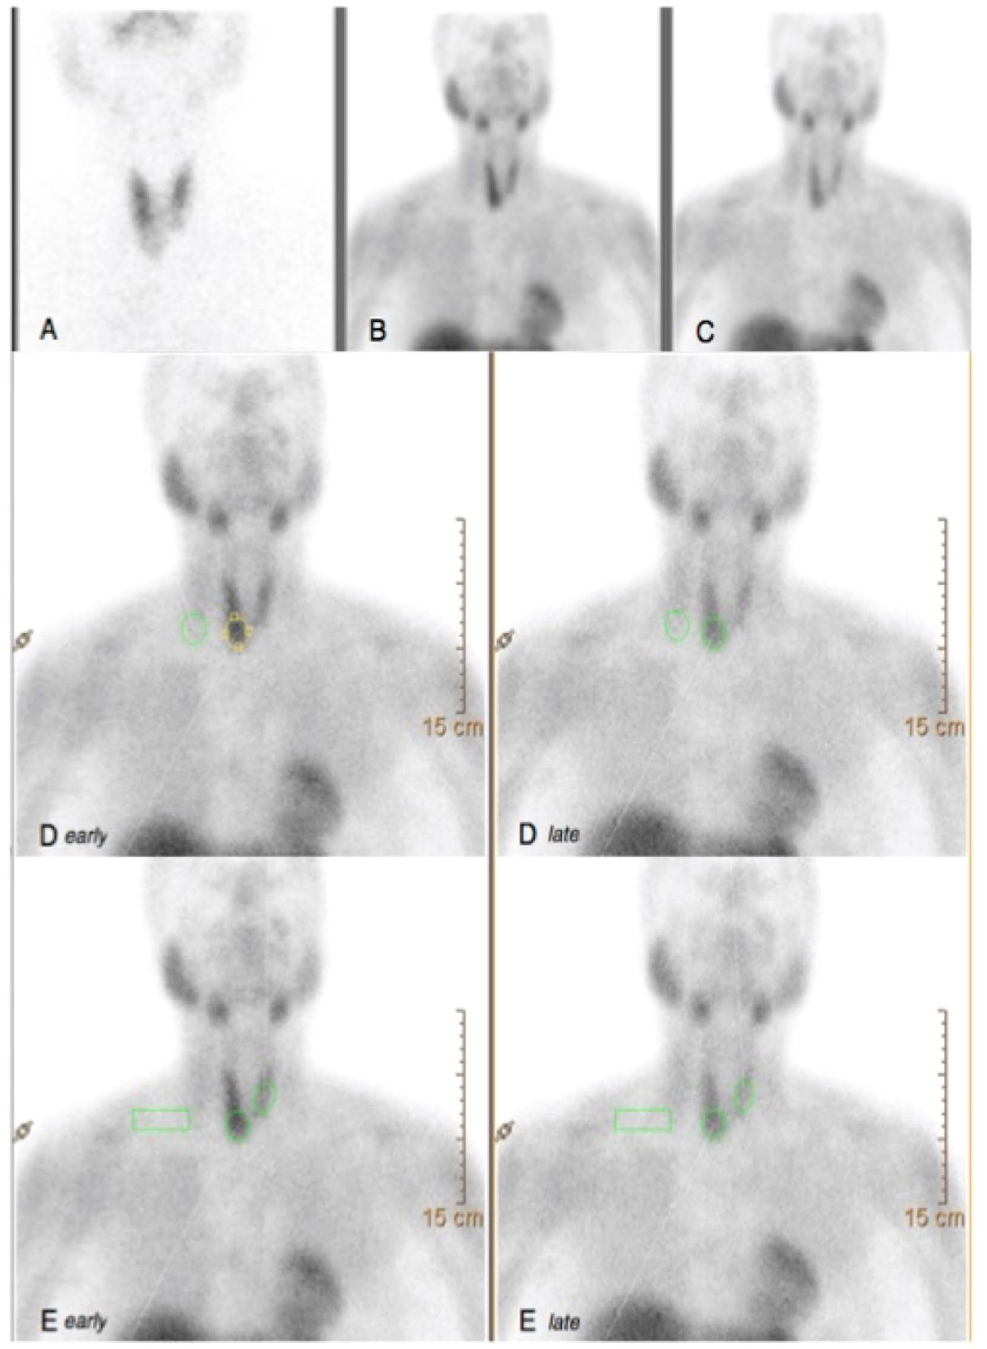
Figure 1. Fifty-two year-old woman with a single nodule located in the right lobe. The nodule (35 mm in maximum diameter) presented a 4B pattern at US (TI-RADS classification). ( A ) 99m Tc-pertechnetate (111 MBq) thyroid scintigraphy showed a well defined cold area in the lower third of the right lobe, corresponding to the US nodule. Cytopathological findings were conclusive for a class IV lesion according to the Bethesda system. ( B , C ) 99m Tc-MIBI (370 MBq) thyroid scintigraphy obtained 10 (early) and 60 (late) minutes after tracer administration. Visual MIBI analysis showed an moderate nodular tracer uptake on early image that decreased on late image. ( D ) MIBI quantitative analysis was obtained by drawing ROIs according to WO ind method. ( E ) MIBI quantitative analysis was obtained by drawing ROIs according to R.I. method. Calculated WOind and R.I. were − 33% and 6.6, respectively. The patient underwent total-thyroidectomy with final histology diagnosis consistent benign non-oncocytic